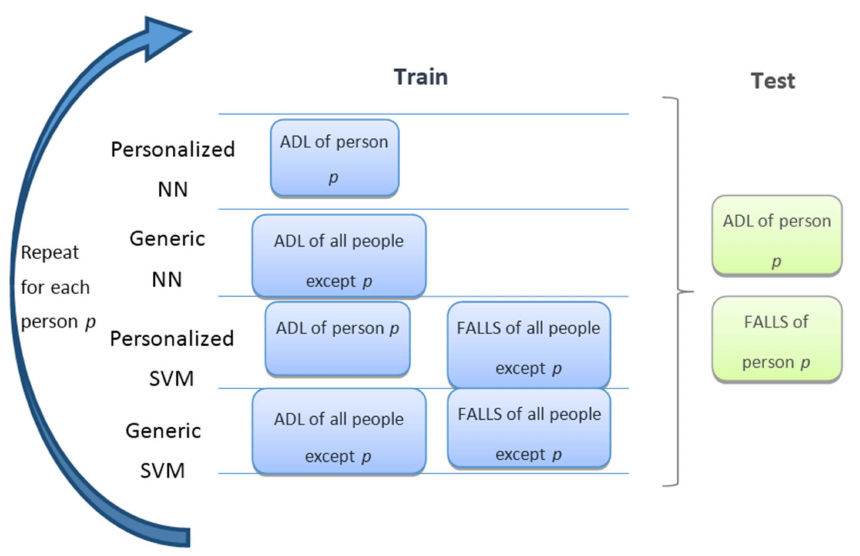
Figure 2. Schematic view of test and training to study the effect of personalization. Boxes of different colors with the same label represent different parts of a dataset. For each subject, the process was repeated 10 times for